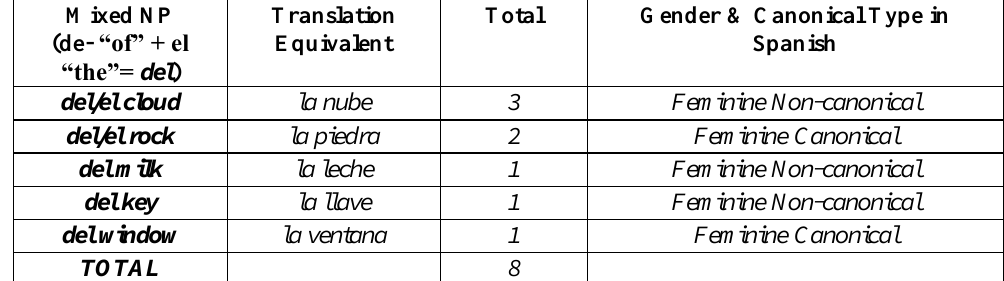
Table 8. Mixed NPs containing a masculine determiner and an English noun with a Spanish feminine translation